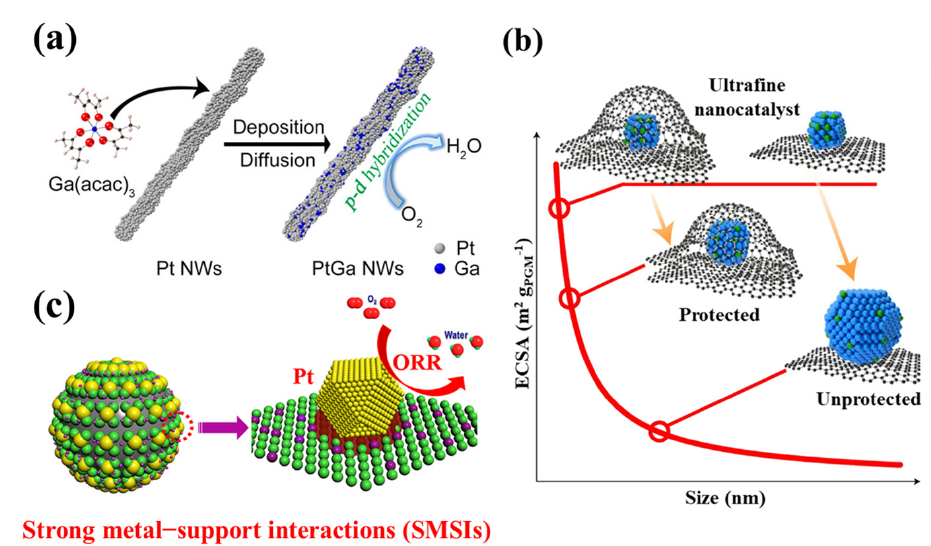
Figure 3. Catalyst performance enhancement through structural optimization: ( a ) Diagram of the design of PtGa NWs. Reprinted with permission from Ref. [48]. Copyright 2019, ACS. ( b ) Diagram showing the protective effect of special support on ultrafine catalysts. Reprinted with permission from Ref. [49]. Copyright 2022, Springer Nature. ( c ) Schematic of the SMSI effect between Pt and support. Reprinted with permission from Ref. [50]. Copyright 2018, Elsevier.